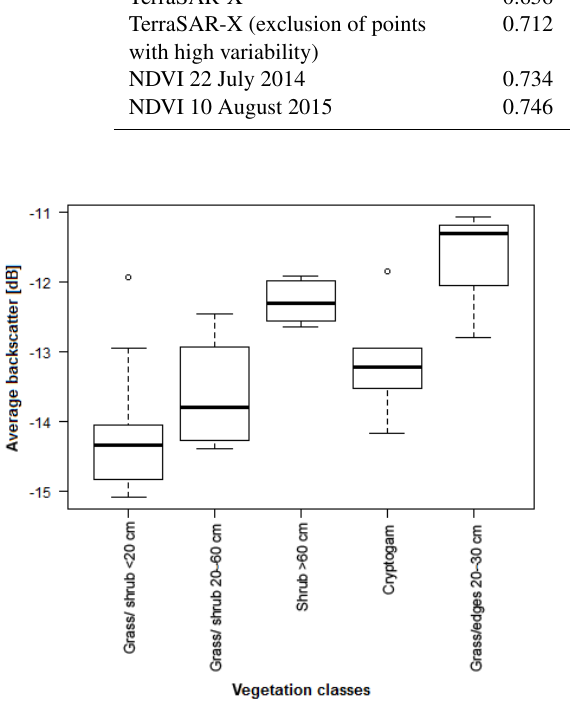
Figure 2. Box plot for backscatter values of various vegetation types. The points used were recorded within a field campaign in 2014. Backscatter values were extracted from the temporally aver- aged and spatially filtered image of August 2014 and 2015 acquisi- tions.